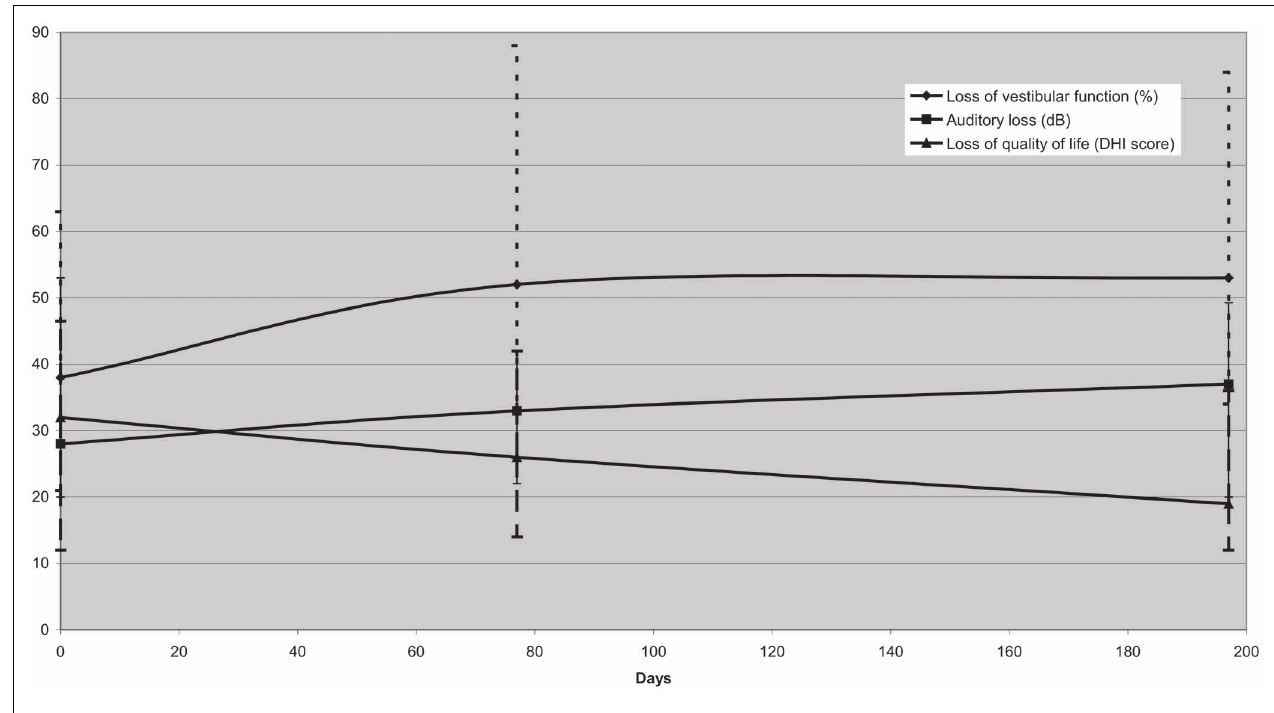
follow-up 1, and follow-up 2 forVS < 20mm (median; interquartile range). Despite a moderate deterioration of vestibular function, quality of life